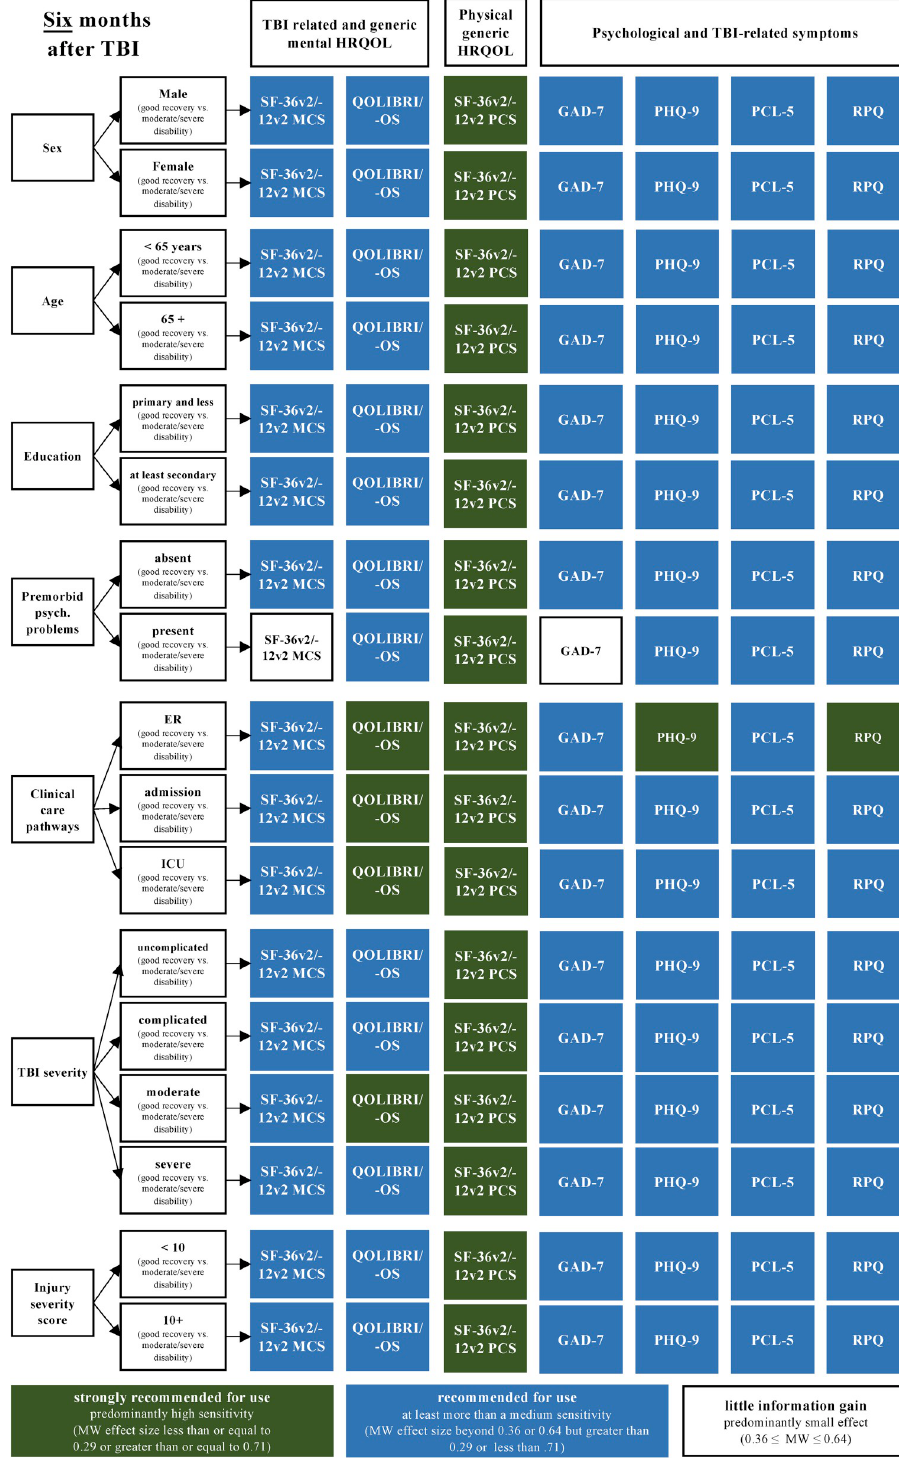
Fig 5. PROMs recommended for use with respect to different sociodemographic, premorbid, and injury-related patient groups and recovery statuses (i.e., GOSE/-Q as reference) at six months after TBI based on the MW effect sizes. Numbers are documented in S7 Table (data as available) and S8 Table (completers).